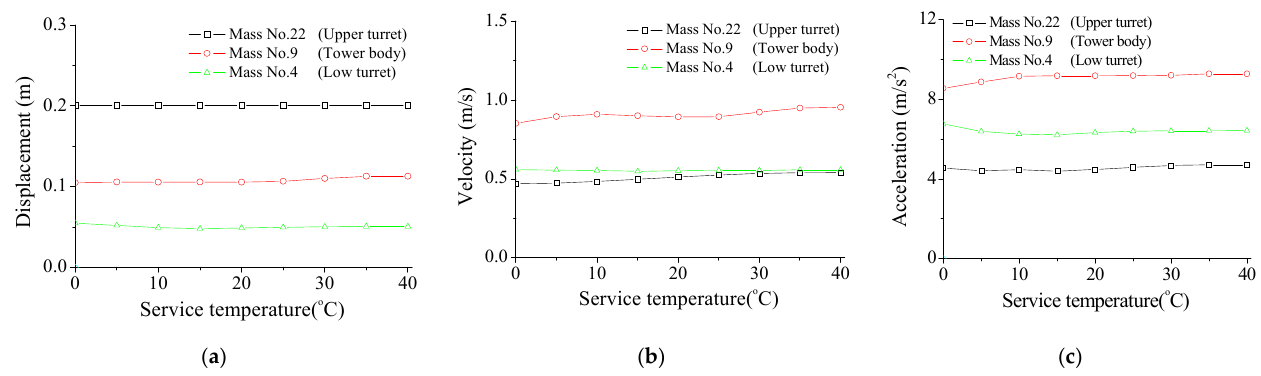
Figure 12. Effects of service temperature on maximum responses of the tower. ( a ) Displacement; ( b ) Velocity; ( c ) Acceleration.